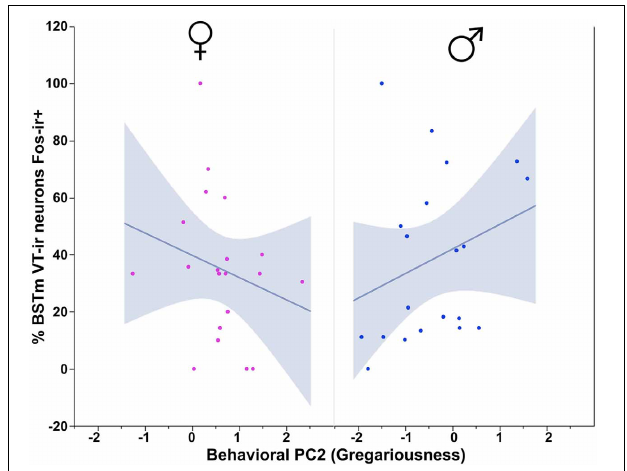
FIGURE 2 | VT-Fos colocalization in the BSTm as a function of an interaction between Sex and Behavioral PC2 (Gregariousness). Gregariousness tends to correlate positively with VT-Fos colocalization (percent of VT neurons co-expressing Fos) in males but not females. Sex × Behavioral PC2 interaction, F ( 1 , 32 ) = 6 . 597, p = 0 . 02. The 95% confidence interval is indicated by shading.